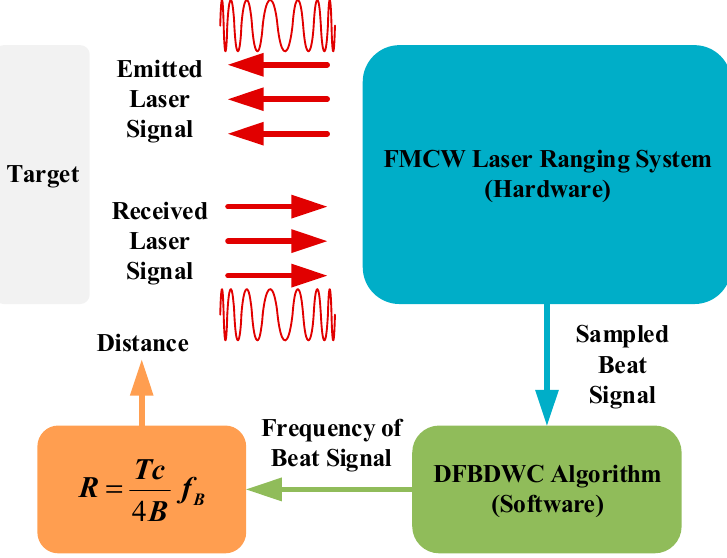
Figure 1. Schematic diagram of distance obtained by the FMCW laser ranging system and DFBDWC algorithm.